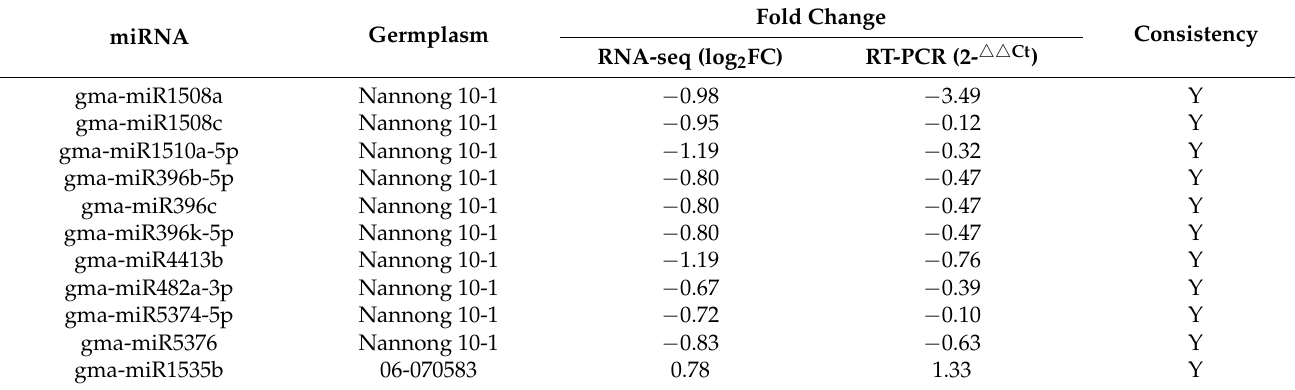
Table 4. Real-time RT-PCR analysis of P. sojae -responsive miRNAs.